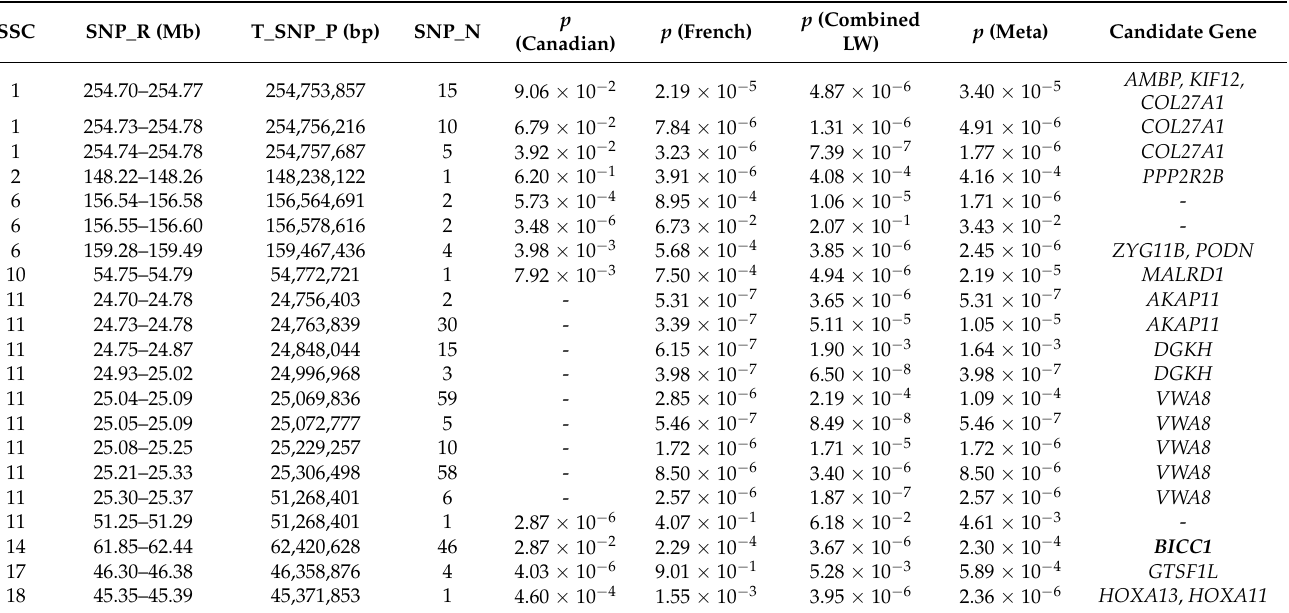
Table 5. The genome significant and suggestive SNPs for the gestation length (GL) trait using imputed WGS data in pigs.